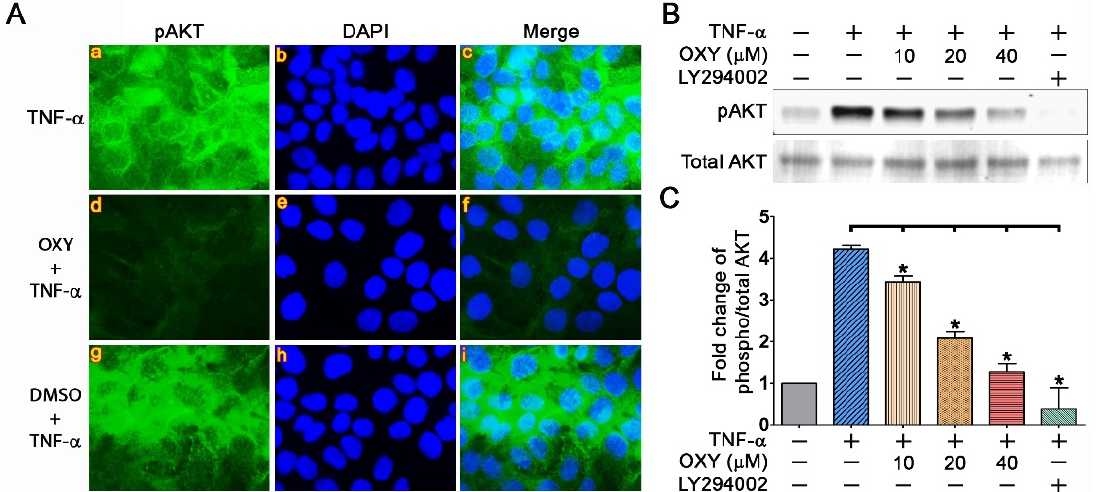
Figure 4. Effects of OXY on blocking TNF- α -stimulated AKT phosphorylation. ( A ) Immunofluores- cence study detecting pAKT (green) in individual cells treated with 40 μ M for 3 h and stimulated with 100 ng/mL TNF- α for 40 min. Nuclei were counterstained with DAPI (blue), visualization was performed at 100× magnification. ( B ) Western blot analysis showing dose-dependent effects of OXY on suppressing AKT phosphorylation. LY294002, a PI3K inhibitor, was used as a positive control. ( C ) Densitometric quantification of pAKT immunoreactive bands. * p < 0.05 in comparison to the TNF- α -treated group.